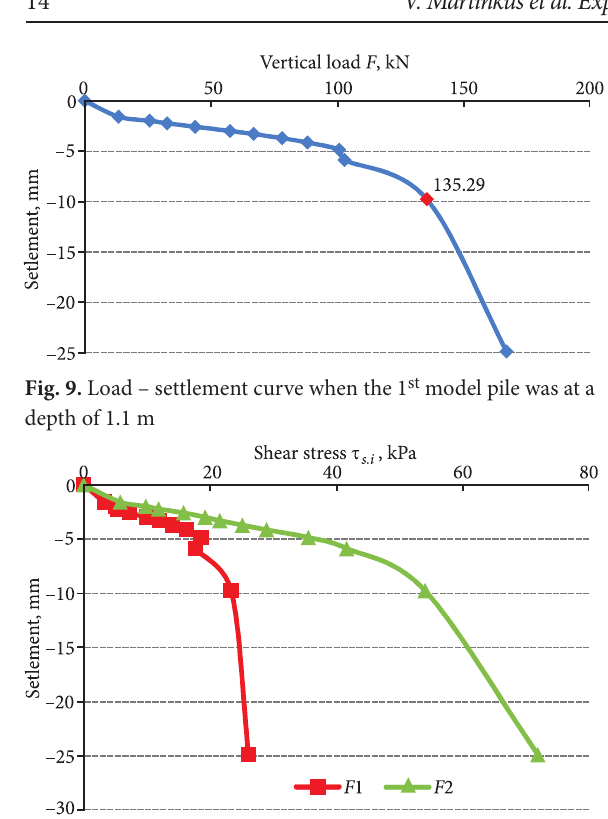
fig. 10. Distribution of shear stress during static vertical load test when the 1 st model pile was at a depth of 1.1 m